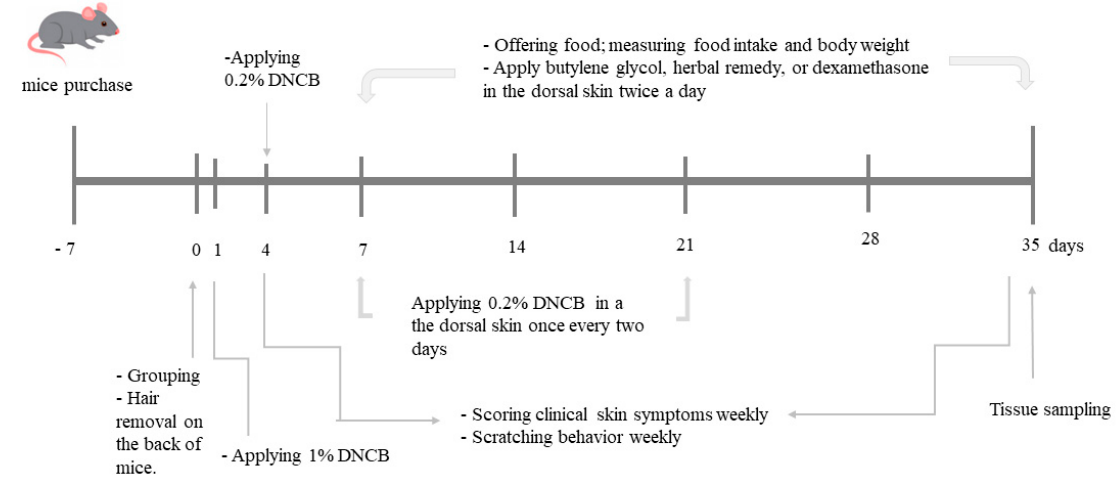
Figure 1. Experimental design.